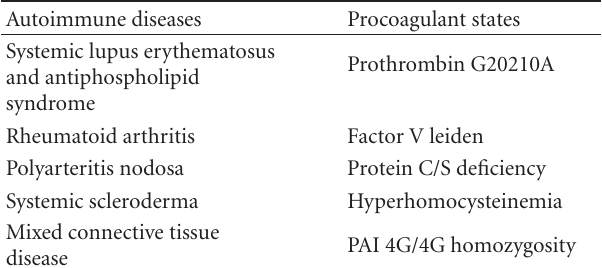
Table 2: Some of the conditions associated with